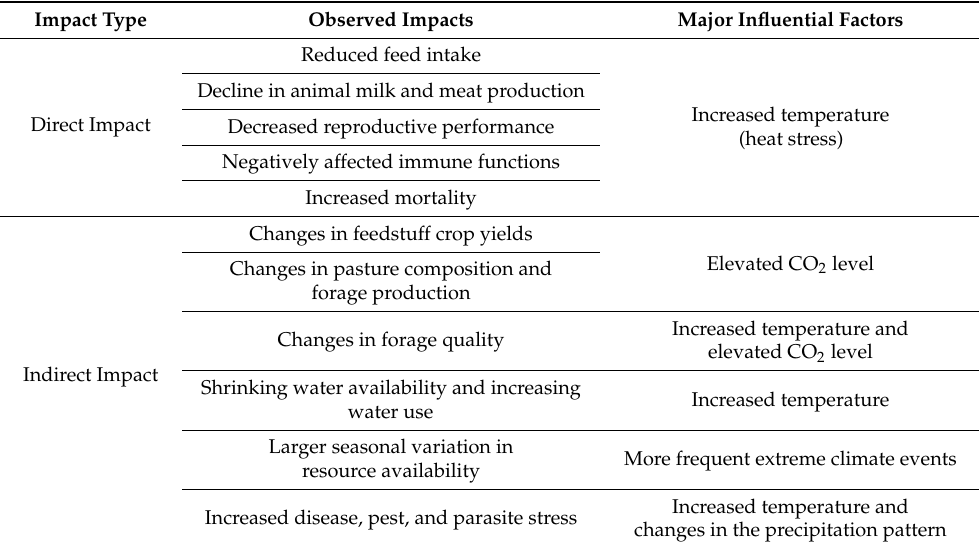
Table 2. Climate change impacts on livestock